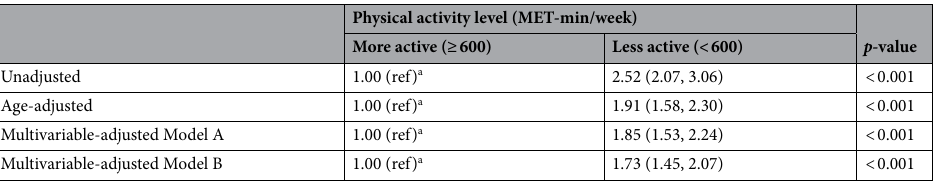
Table 4. Hazard ratio (95% CI) for all-cause mortality according to physical activity level. Data are representative of non-institutionalized American population. Model A is adjusted by age, sex, race/ethnicity, annual household income, and educational level. Model B is additionally adjusted by alcohol consumption, smoking status, BMI, arterial hypertension, dyslipidemia, and diabetes. a Significant differences between Less- active and More-active groups.